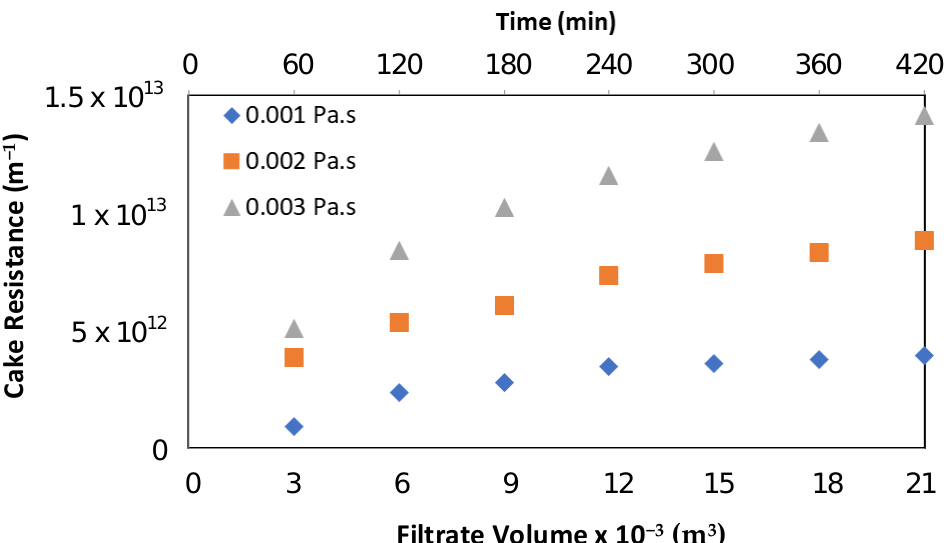
Figure 3. Effect of viscosity on R c at different concentrations of viscosity with an airflow rate of 1.2 m 3 /m 2 /h.